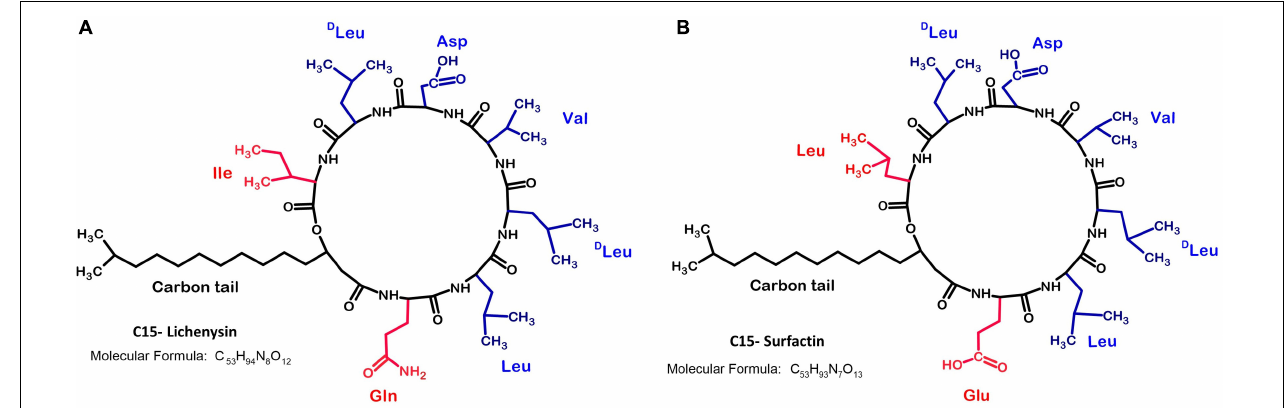
FIGURE 1 | Chemical structures of C15-lichenysin and C15-surfactin. (A) C15 Lichenysin; (B) C15- Surfactin; The lipopeptide lichenysin A (cyclo-[Gln 1 -Leu 2 -Leu 3 -Val 4 -Asp 5 -Leu 6 -Ile 7 − − β -OH fatty acid]) produced by B. licheniformis (Yakimov et al., 1995) is structurally similar to surfactin (cyclo-[Glu 1 -Leu 2 -Leu 3 -Val 4 -Asp 5 -Leu 6 -Leu 7 − − β -OH fatty acid]) produced by B. subtilis (Zhao et al., 2017), which was first discovered by Arima et al. (1968). The 1st and 7th position of the peptide ring differs between surfactin and lichenysin